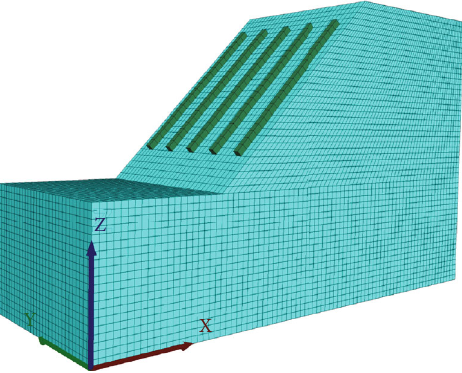
Figure 11: Numerical model